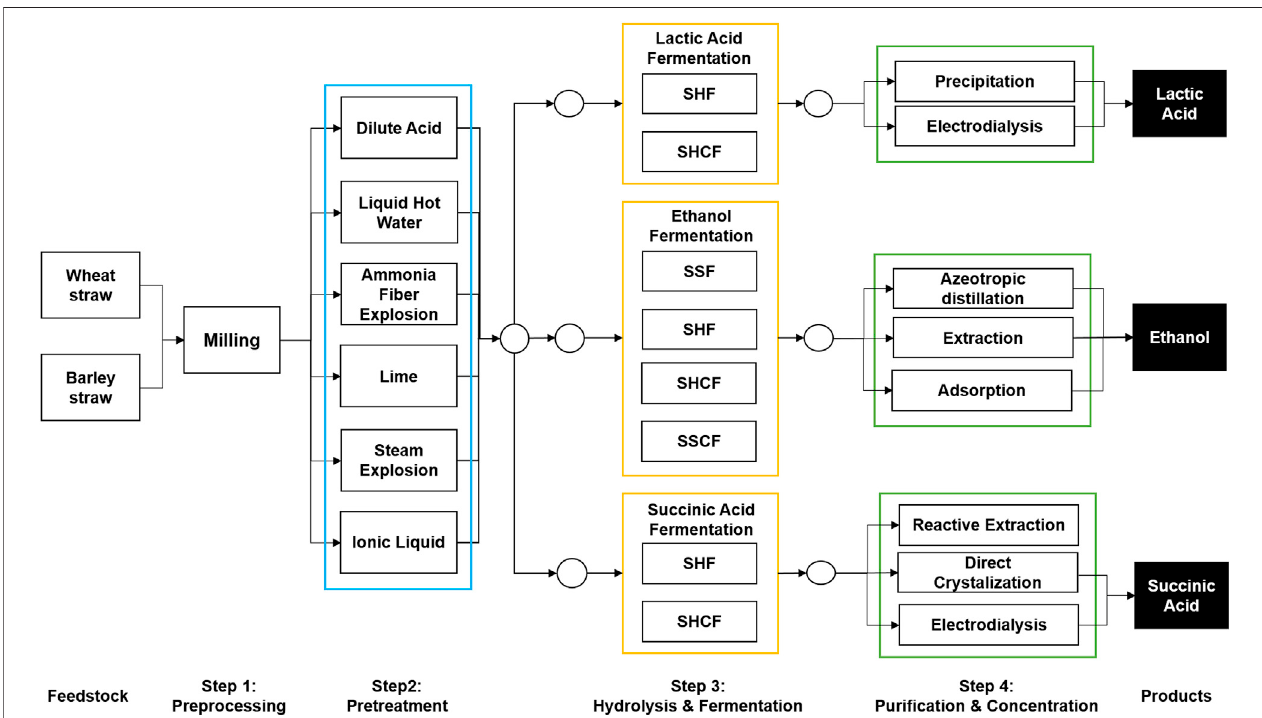
FIGURE 2 | Superstructure of alternatives for the conversion of LCF into value-added products. SHF: separate hydrolysis and fermentation; SHCF: separate hydrolysis and co-fermentation; SSF: simultaneous sacchari fi cation and fermentation; SSCF: simultaneous sacchari fi cation and co-fermentation.